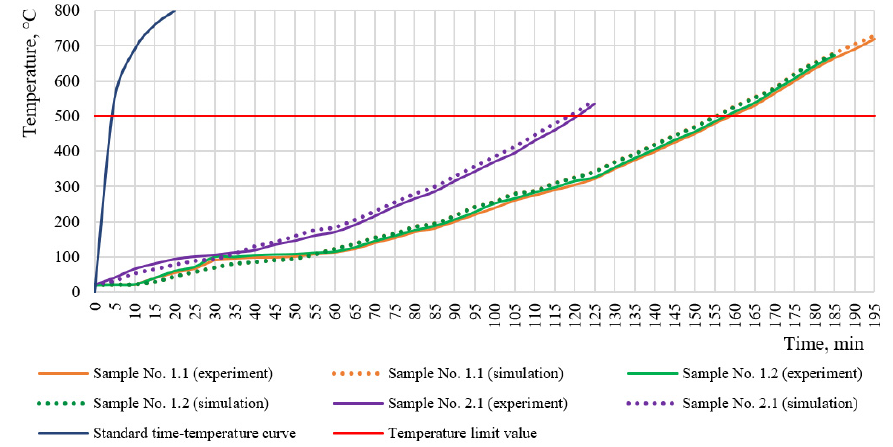
Figure 9. Experimental and calculated temperature curves of samples during fire exposure under standard fire regime.